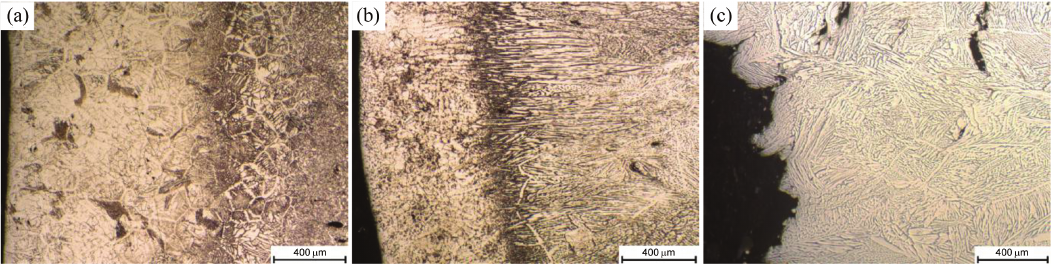
Figure 7: Microstructures of specimens near the tensile fracture: (a) 1,000°C, (b) 800°C and (c)